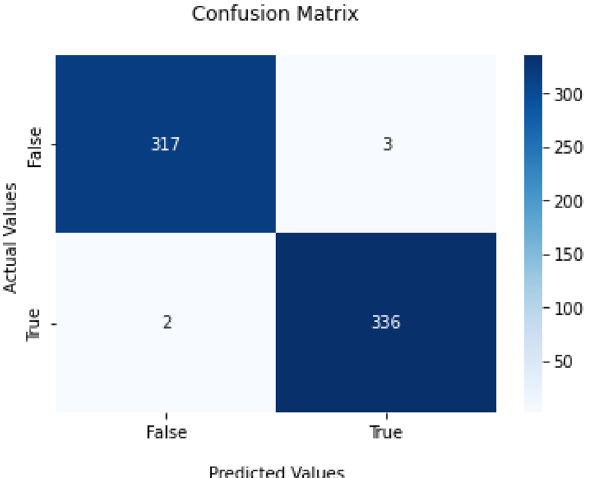
Figure 10. Confusion matrix.